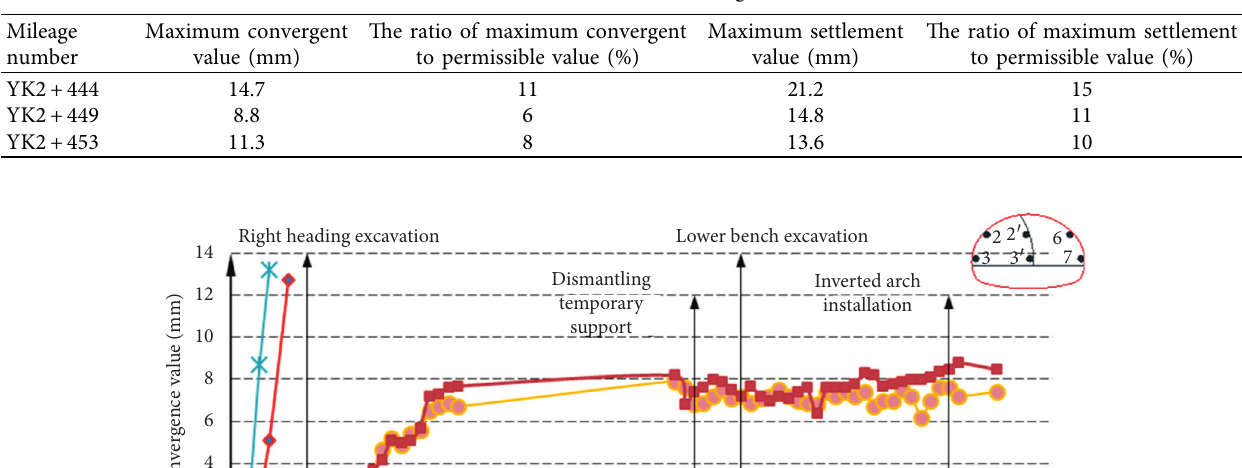
Table 4: Deformation monitoring